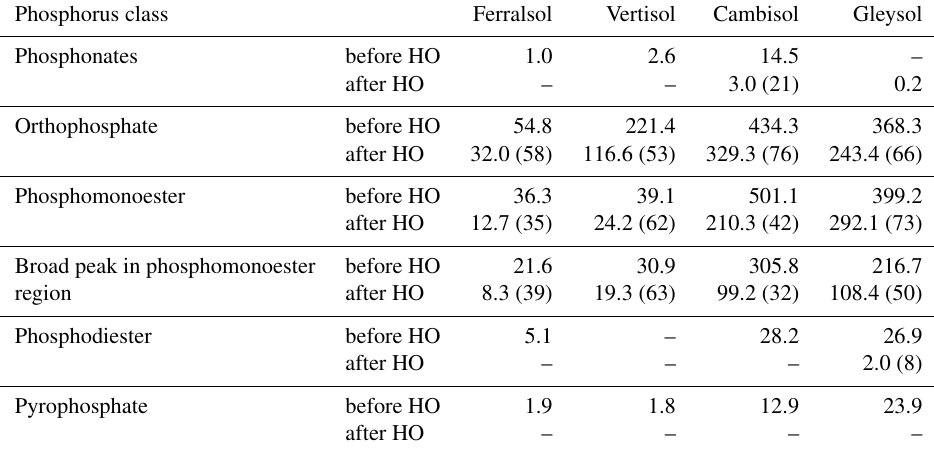
Table 4. Concentrations (mgP per kg soil) of P compounds in solution 31 P NMR spectra of 0.25M NaOH + 0.05M EDTA soil extracts (Ferralsol, Vertisol, Cambisol and Gleysol) before and after hypobromite oxidation (HO). Quantification was based on spectral integration and deconvolution fitting. The proportion of P detected in hypobromite oxidised extracts compared to that in untreated extracts is provided in